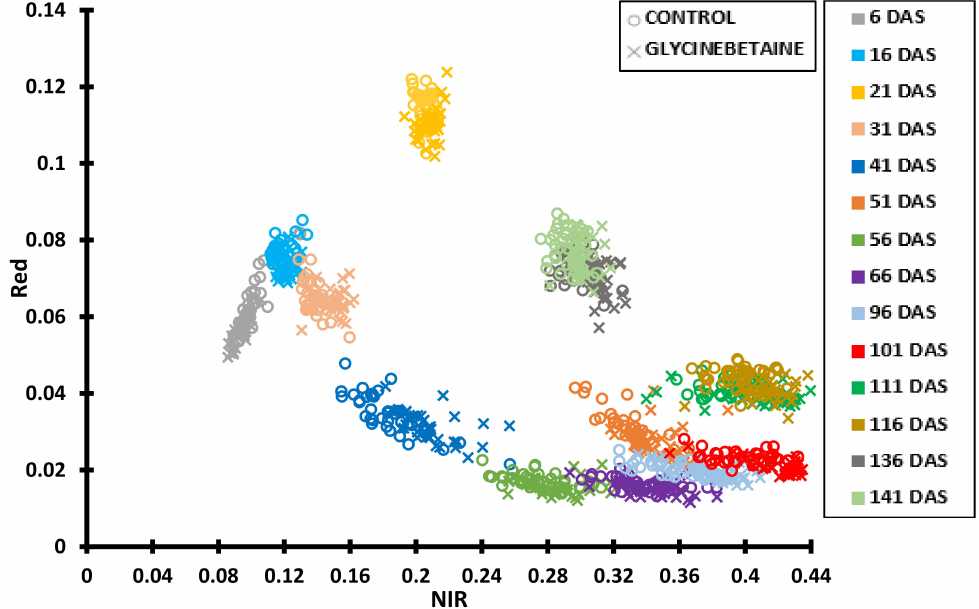
Figure 5. Red– NIR surface reflectance dynamics for the entire rice crop season.